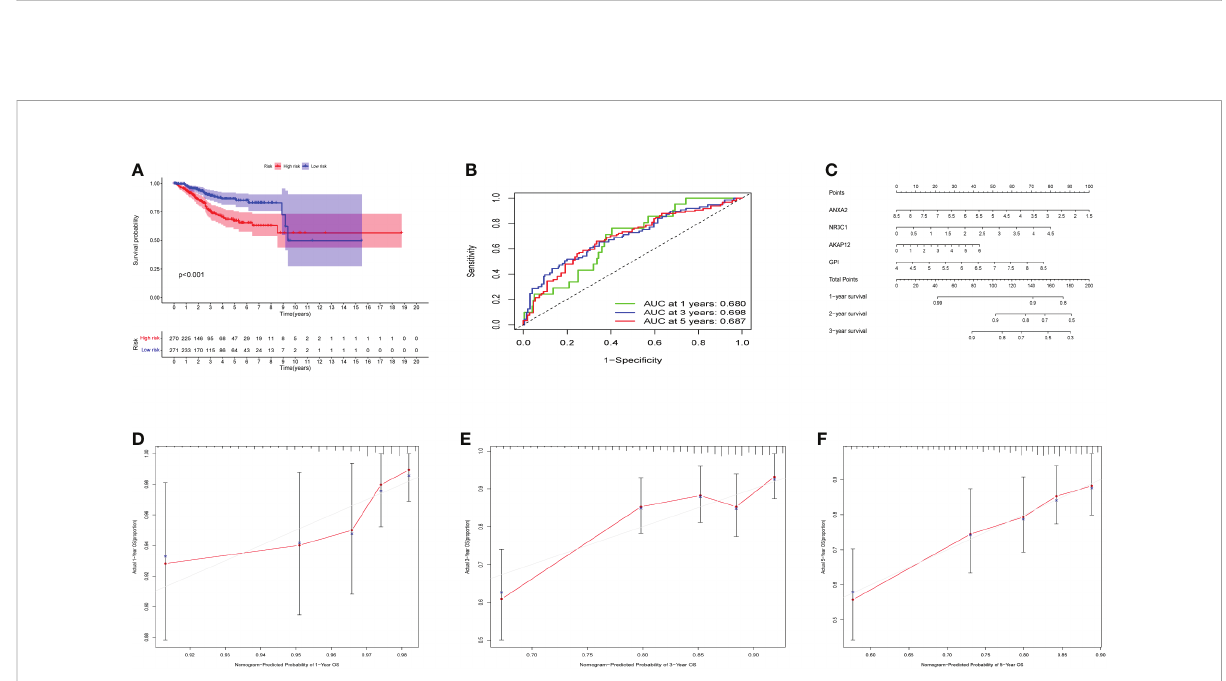
FIGURE 4 Effects of the hypoxia model on patient prognosis. (A) Kaplan – Meier survival curves for patients, strati fi ed according to risk scores; comparison of the median survival time with log-rank tests ( p < 0.001). (B) Receiver operating characteristic curve analysis of the prognostic accuracy of the model. (C) Nomogram based on four genes for predicting the prognostic survival rate of patients. (D-F) Calibration curves of the nomogram for predicting the survival outcomes at 1-, 3-, and